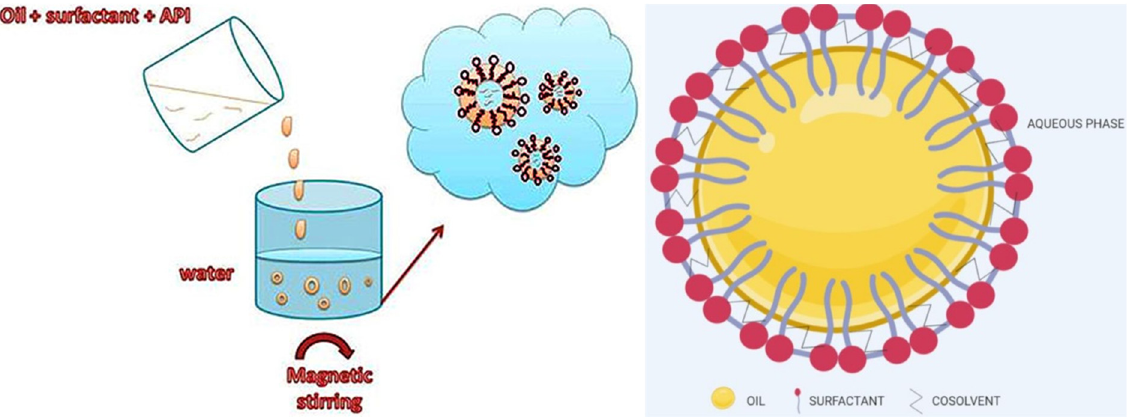
Figure 7. The formulation of SNEDDS and typical structure of SNEDDSs. Adapted from [109], Copyright 2013 OSPC and adapted from [110], Copyright 2020 MDPI.